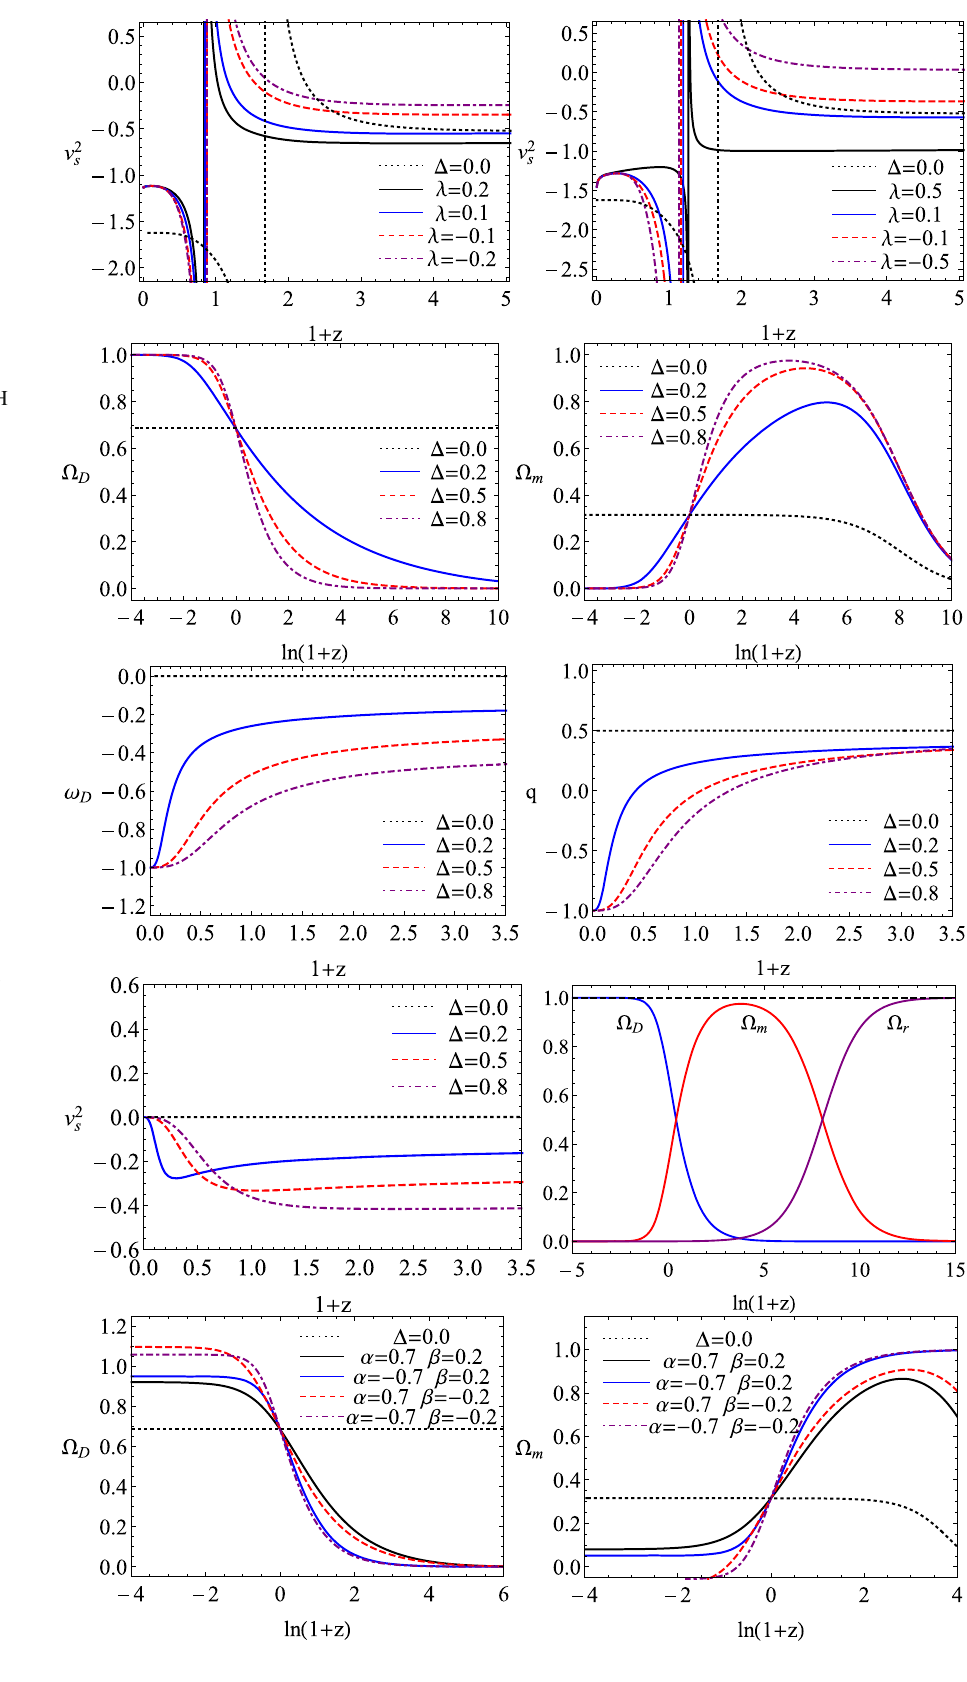
Fig. 9 Evolution curves of v 2 s versus redshift parameter for IBHDEFL. The left panel was plotted for (cid:5) = 0 . 1 , C = 3 . 5, while the right one was shown for (cid:5) = 0 . 2 , C = 4 . 0